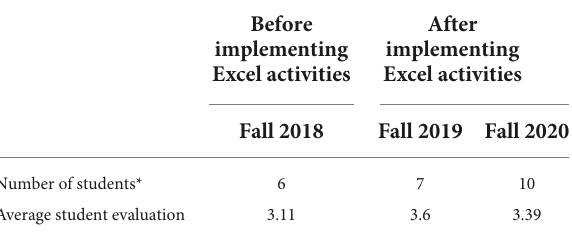
TABLE 4 Before-after comparison of implementing Excel spreadsheet, CE 401.